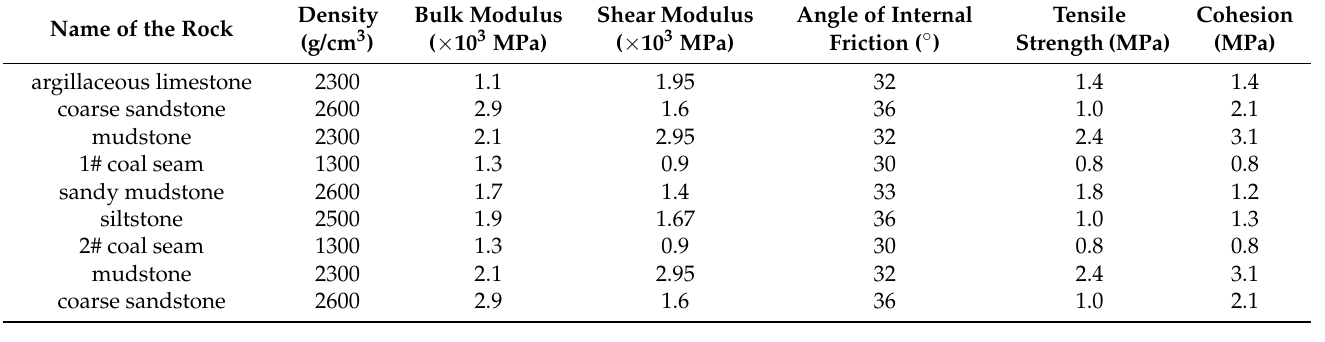
Table 1. Physical and mechanical property parameters of coal and rock mass.